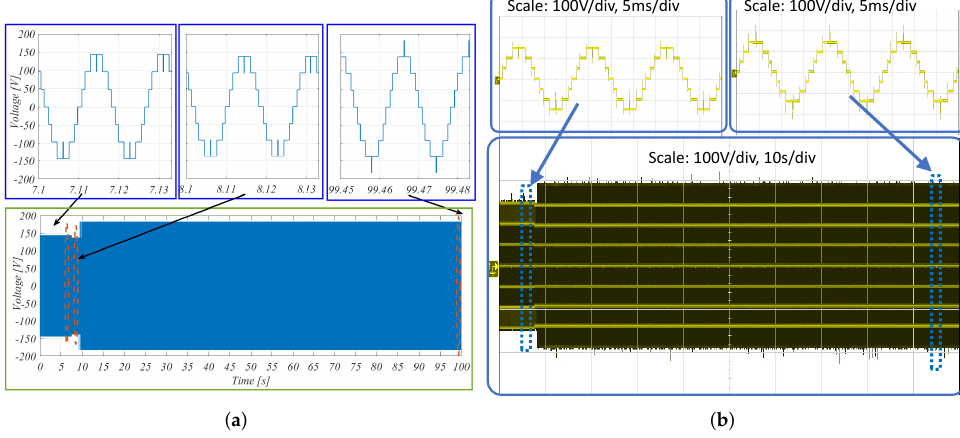
Figure 10. ( a ) Simulation result of 200 W load insertion, ( b ) Experimental result of 200 W load